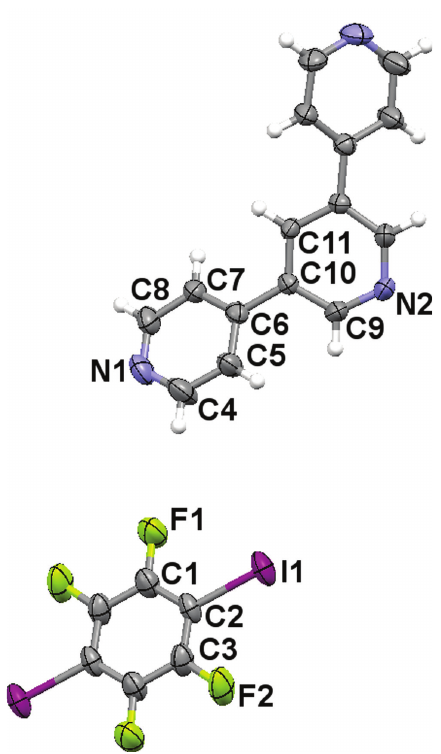
Table 1: Data collection and handling.